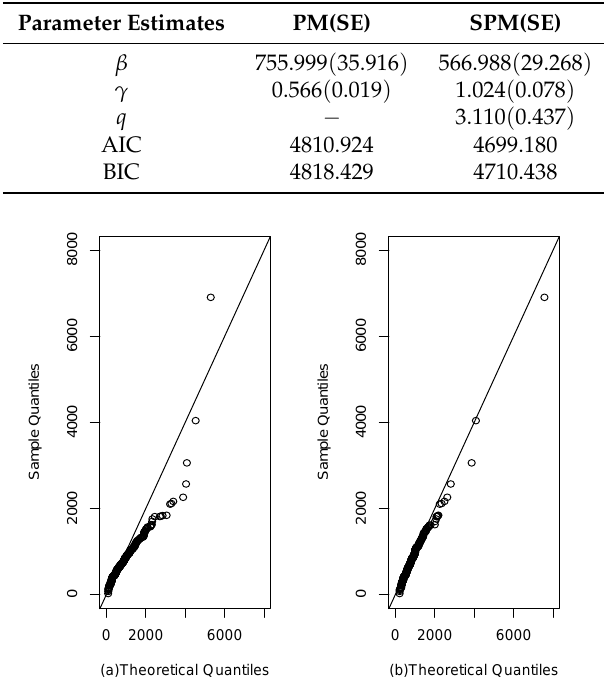
Table 6. Parameter estimates, (SE) indicates standard error estimates, and log-likelihood values for PM and SPM models for the dietary retinol concentration.